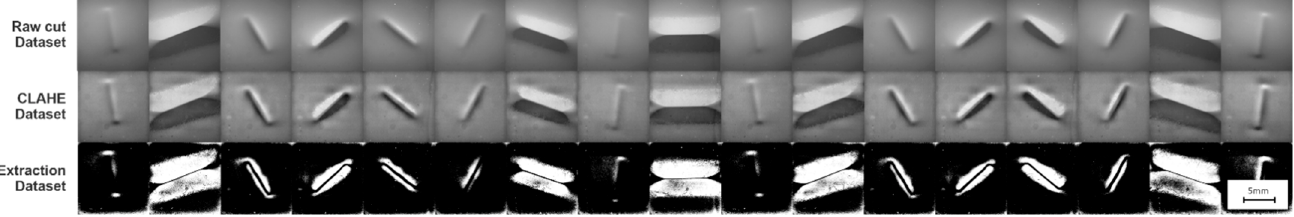
Figure 7. Three variation datasets: raw cut image, CLAHE image, and extraction image.